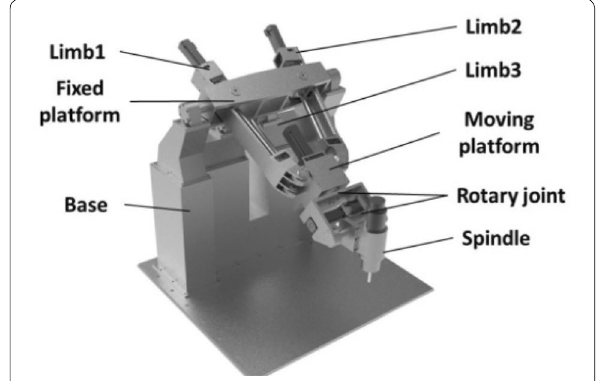
Figure 1 Structure of the PKM